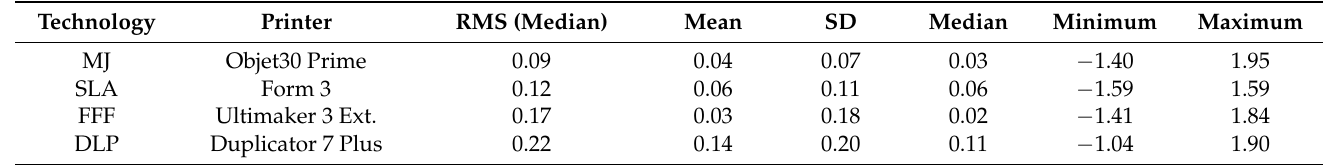
Table 4. Summary of the described values in the point cloud dataset (mm) for each